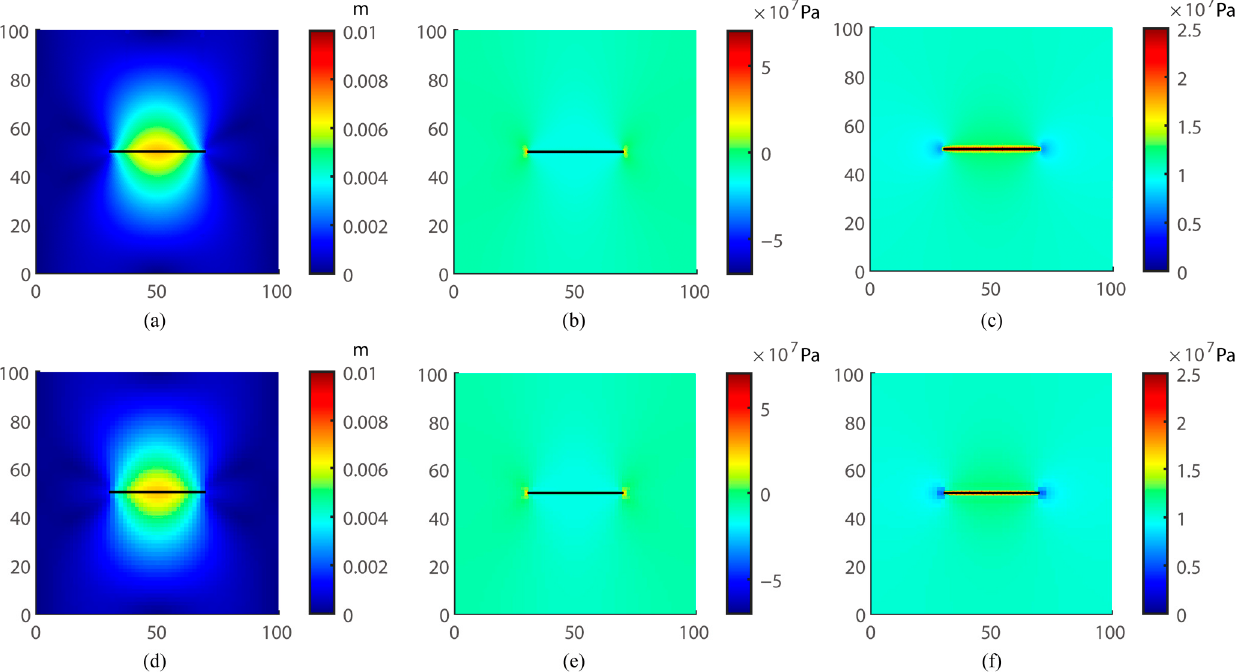
Figure 8. Distributions of the displacement, Effective stress component σ ( a ) Displacement distribution calculated by COMSOL, ( b ) Effective stress component σ calculated by COMSOL, ( c ) Pressure distribution calculated by COMSOL, ( d ) Displacement distri‑ bution calculated by UXFEM, ( e ) Effective stress component σ ( f ) Pressure distribution calculated by